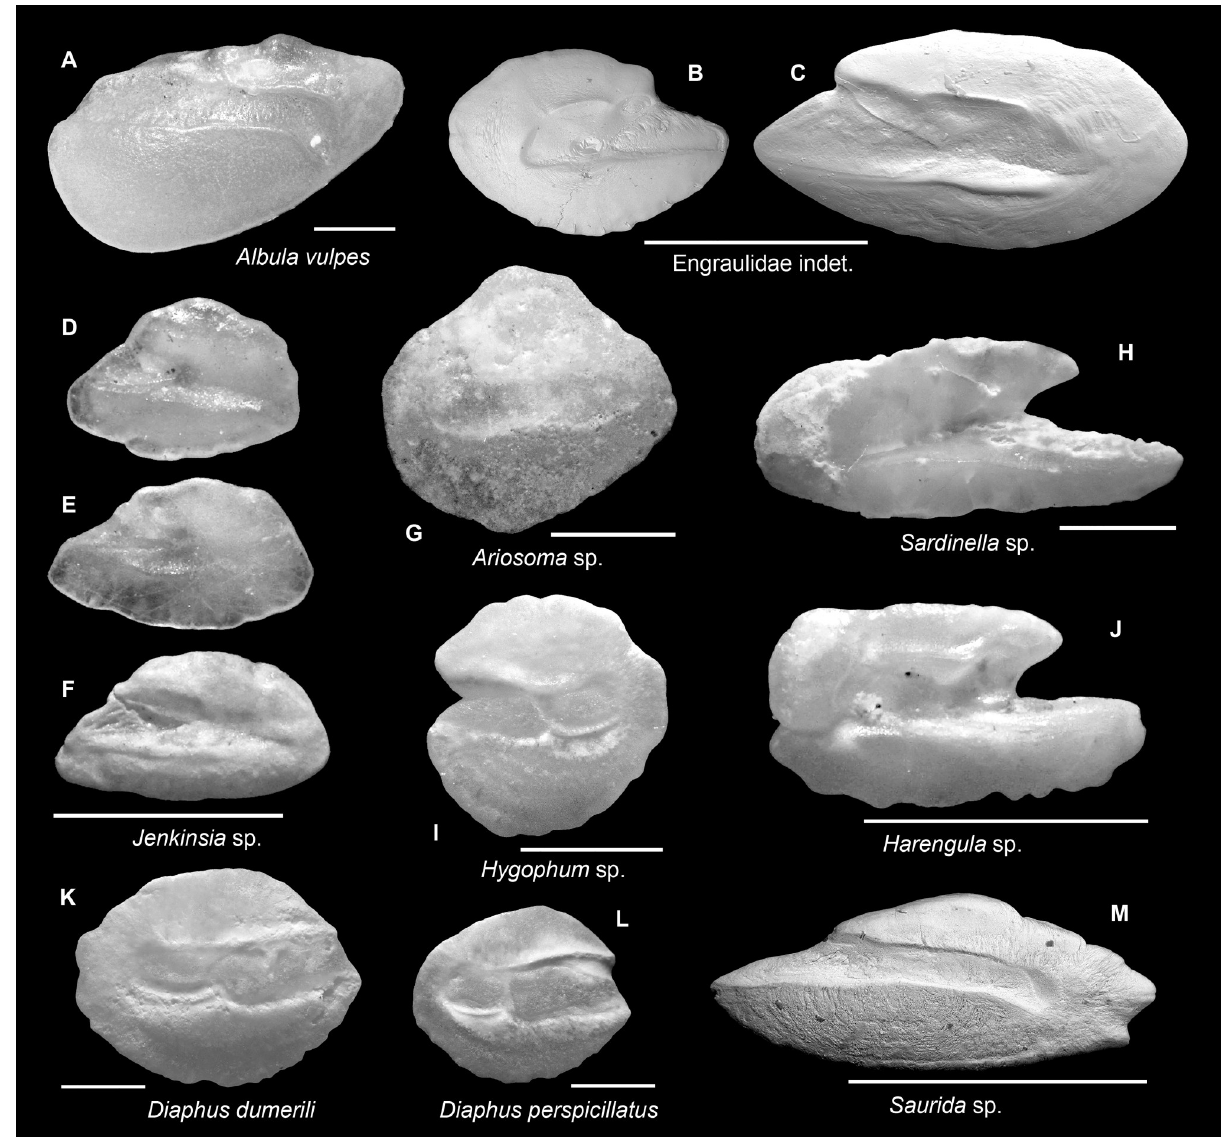
Fig 3. Fish otoliths from the mid-Holocene and sub-Recent reef sediments. Images are inner views and scale bars = 1 mm. A. Albula vulpes , right otolith, mid-Holocene, Sweet Bocas. B, C. Engraulidae indet., mid-Holocene, B, left otolith, Ca ñ on de Buo; C, right otolith, Sunset Point. D-F. Jenkinsia sp., right otoliths, D, mid-Holocene, Sunset Point; E, sub-Recent, STRI Point; F, sub-Recent, Punta Caracol. G. Ariosoma sp., right otolith, sub-Recent, Wreck Limon La Caleta. H. Sardinella sp., left otolith, sub-Recent, Feri, SW Levantado, Samana Bay. I. Hygophum sp., right otolith, sub-Recent, Hickory Ship La Caleta. J. Harengula sp., left otolith, mid-Holocene, Sweet Bocas SE Face. K. Diaphus dumerili , left otolith, sub-Recent, Hickory Ship La Caleta. L. Diaphus perspicillatus , left otolith, sub-Recent, Hickory Ship La Caleta. M. Saurida sp., right otolith, sub-Recent, STRI